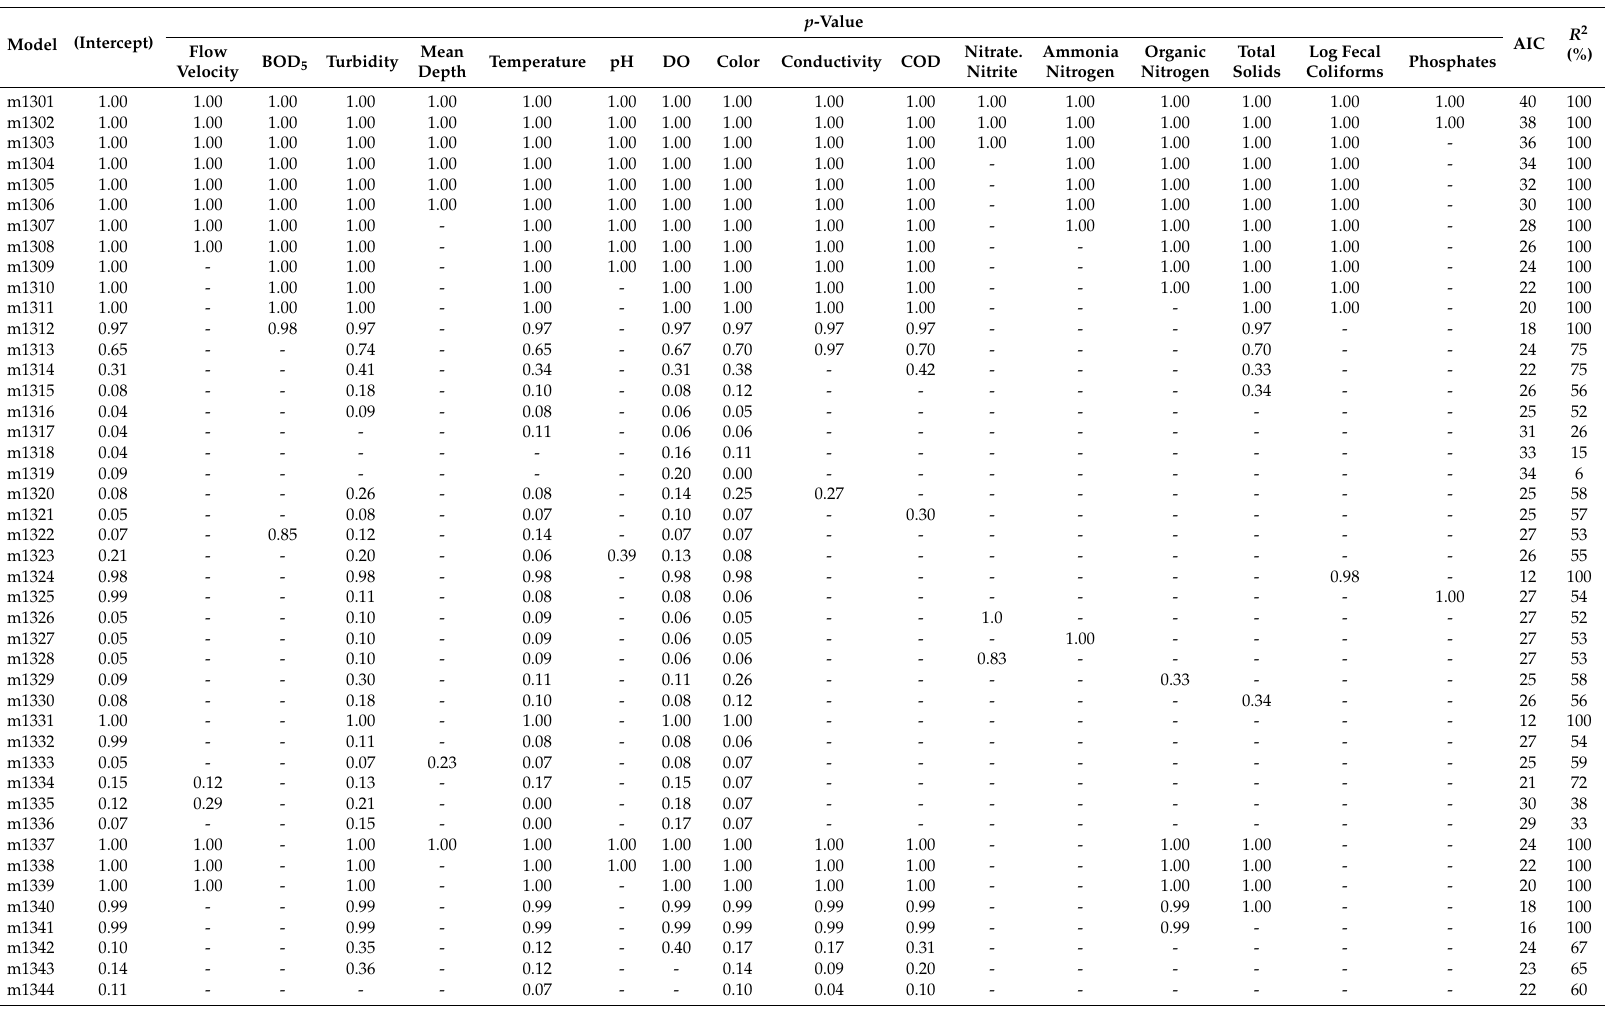
Table A3. Process of model development for Baetidae : p -values, AIC and adjusted R 2 .